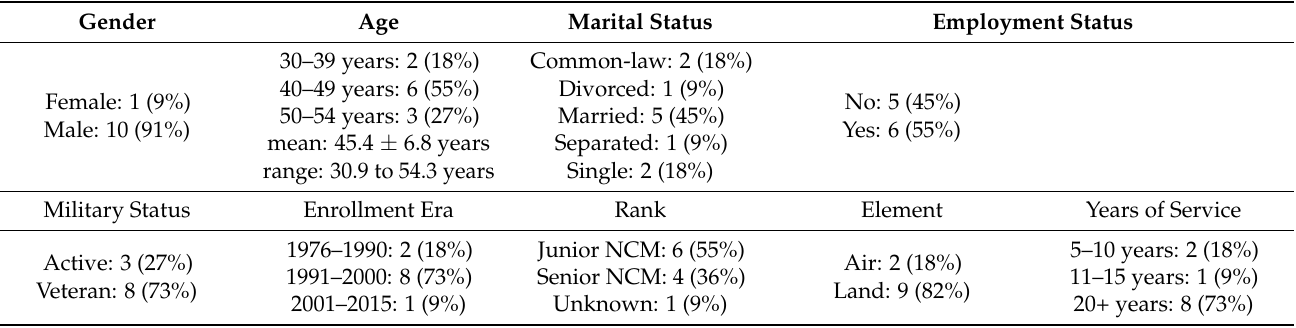
Table 1. Demographics (n =